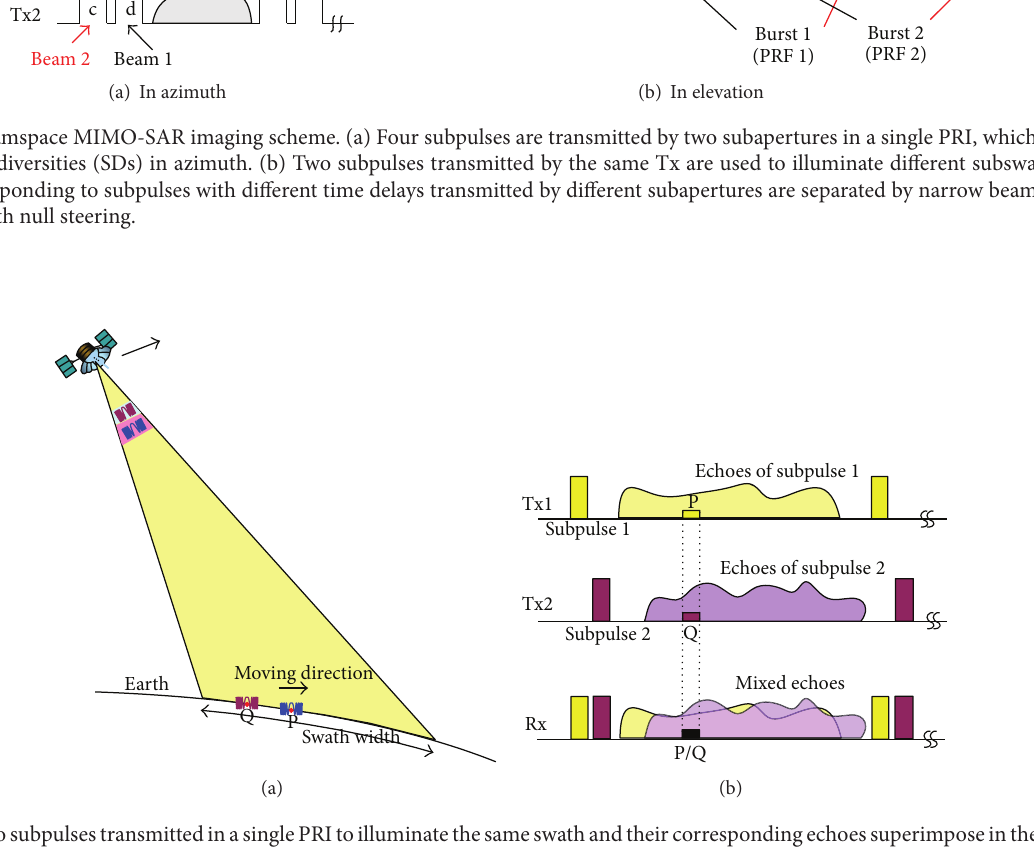
window. (a) Imaging geometry of two subpulses in a single PRI to illuminate the same swath. (b) Echoes of different subpulses superimpose in the receiving